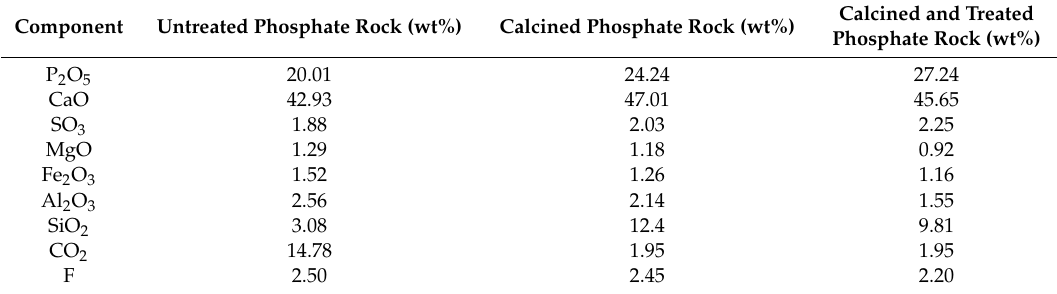
Table 2. Elemental Analysis of Untreated, Calcined, as Well as Calcined and Treated Sra Ouertane (Layer A1) Phosphate